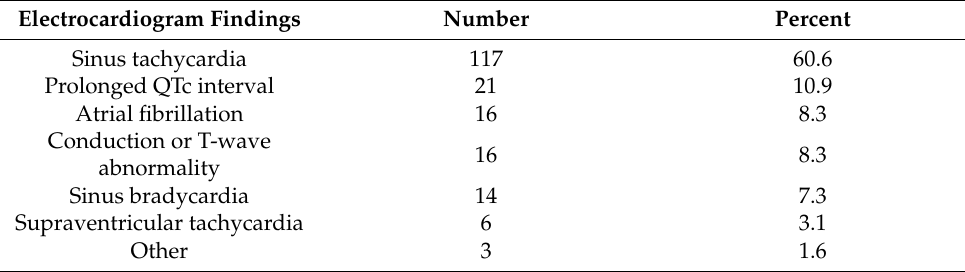
Table 3. Abnormal electrocardiogram findings during MET calls ( n =